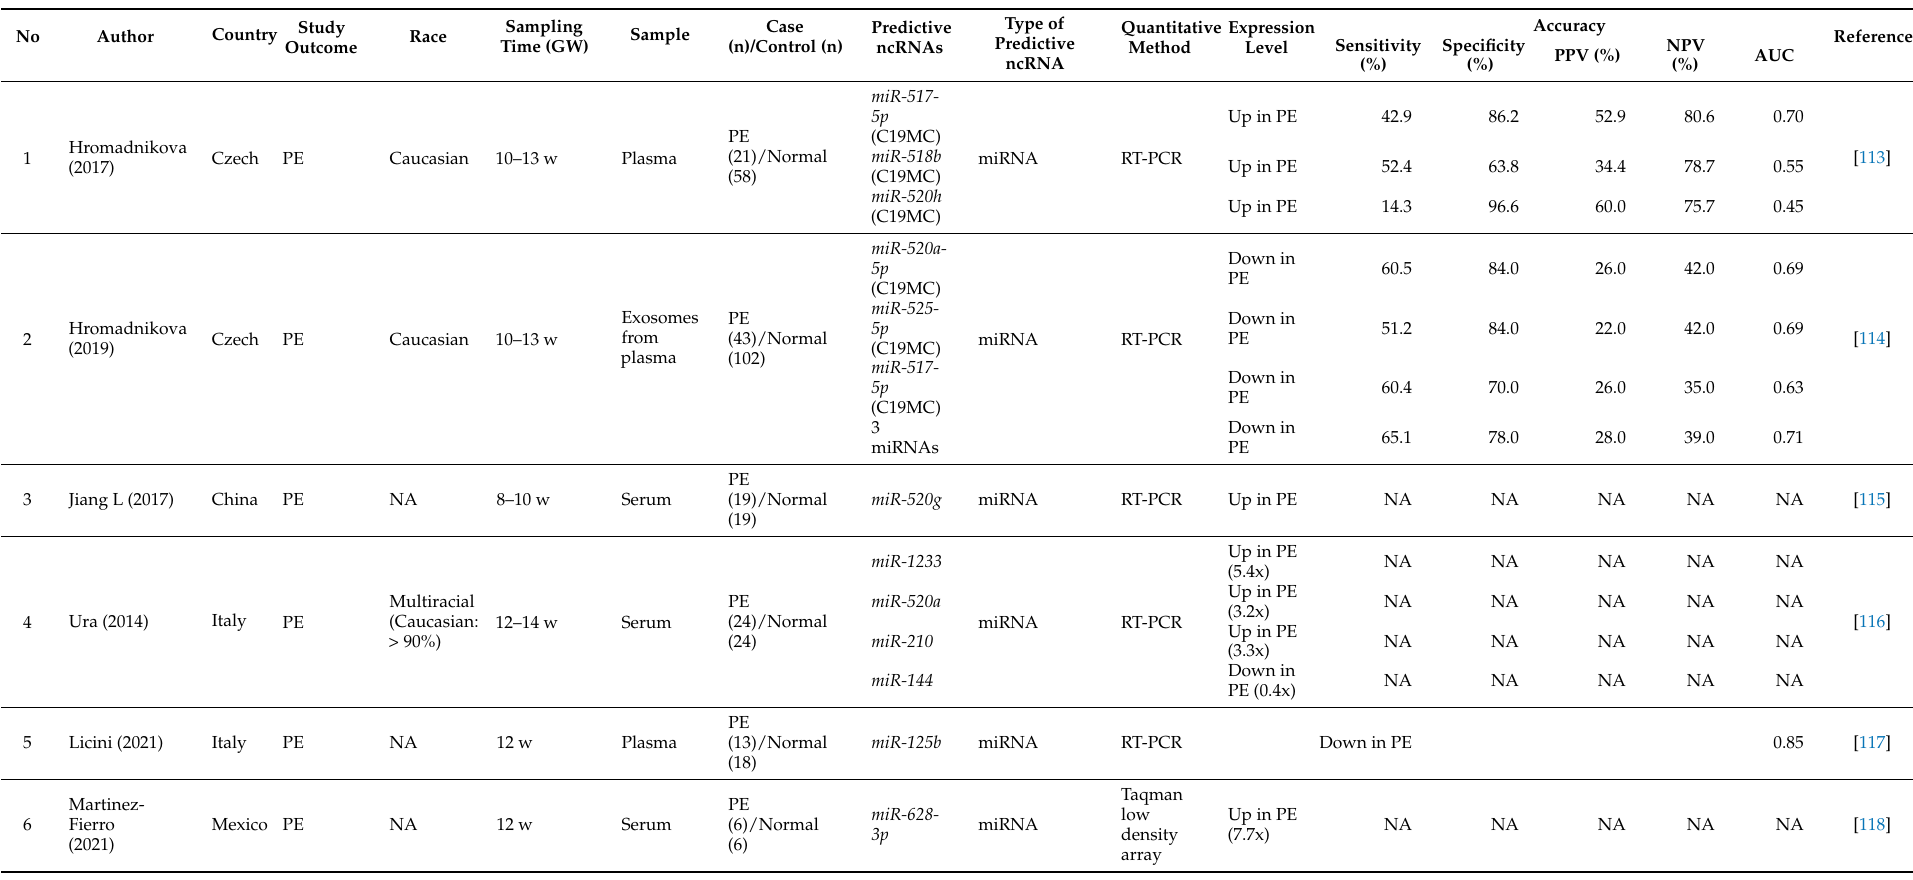
Table 3. Possible maternal circulating non-coding RNA biomarkers for preeclampsia in the 1st trimester obtained from case control